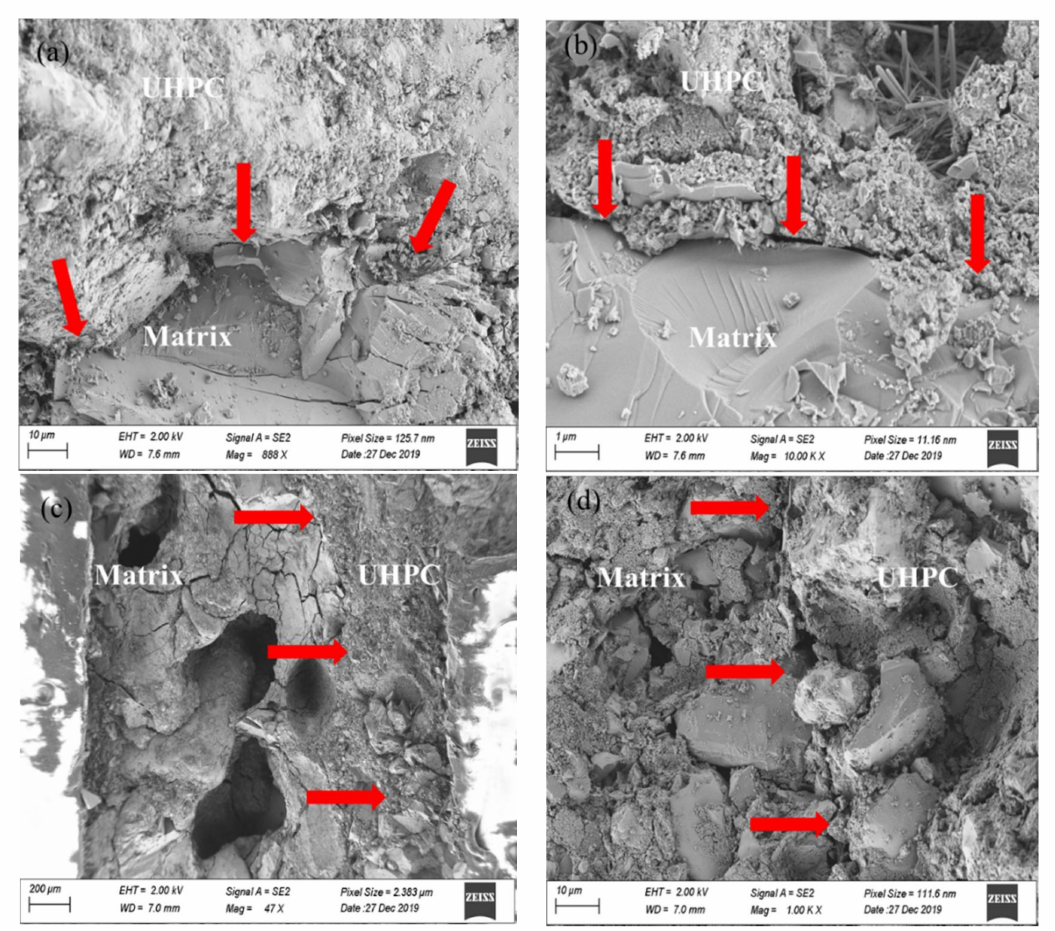
Figure 10. SEM micrographs of the UHPC repaired system: ( a , b ) T1, ( c , d ) T4 (arrows: bond